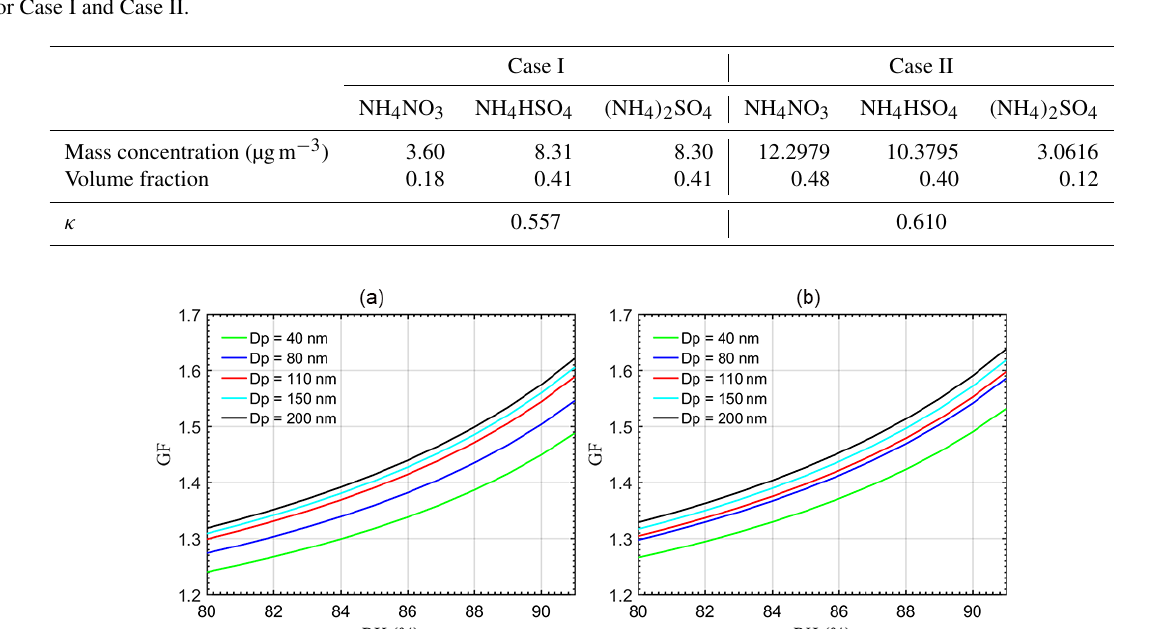
Table 4. Calculated mass concentrations and volume fractions of NH 4 NO 3 , NH 4 HSO 4 , and ( NH 4 ) 2 SO 4 , and the hygroscopicity parameter ( κ ) for Case I and Case II.